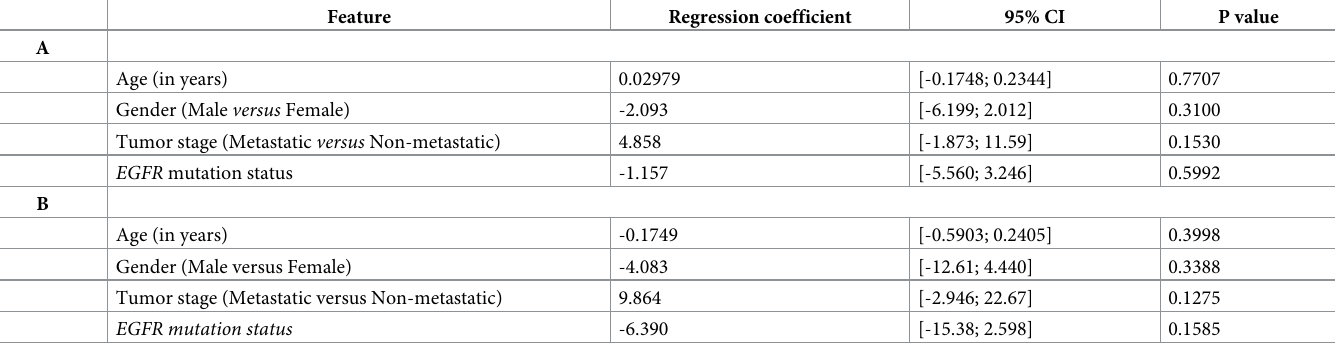
Table 1. Association of LINE-1 . 1 (A) and LINE-1 . 2 (B) methylation status with cancer stage and patients’ demographical characteristics in non-squamous NSCLC analyzed by multiple linear